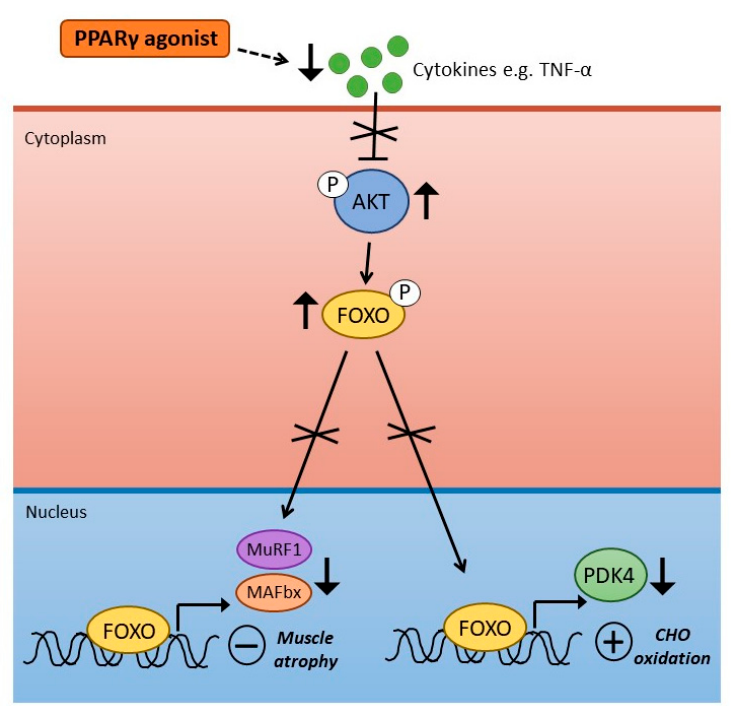
Figure 2. Impact of PPAR γ agonism in skeletal muscle during LPS-induced endotoxaemia. Treatment with PPAR γ agonists during endotoxaemia suppresses production of pro-inflammatory cytokines (e.g., tumour necrosis factor α : TNF- α ). This results in reduced suppression of muscle AKT, and reduced transcriptional activity of Forkhead Box O (FOXO) transcription factors. Reduced activity of FOXO leads to suppression of factors important in increased muscle atrophy (MAFbx and MuRF1) as well as PDK4, a key protein in PDC inhibition.